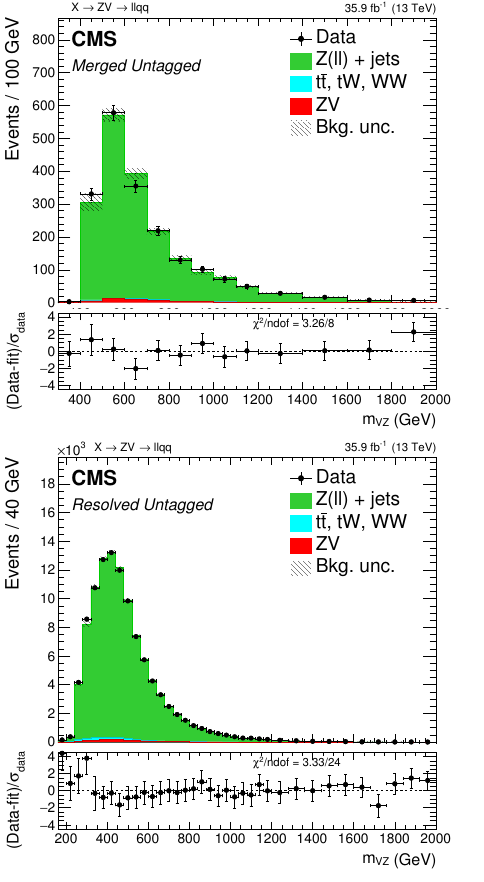
Figure 4 . Sideband m VZ distributions for the low-mass search in the merged V (upper), resolved V (lower), untagged (left), and tagged (right) categories, after (cid:12)tting the sideband data alone. The points show the data while the (cid:12)lled histograms show the background contributions. Electron and muon categories are combined. The gray band indicates the statistical and post-(cid:12)t systematic uncertainties in the normalization and shape of the background. Larger bin widths are used at higher values of m VZ ; the bin widths are indicated by the horizontal error